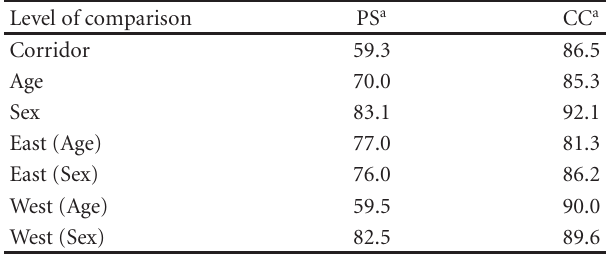
Table 5: Percent Similarity (PS) and Coe ffi cient of Community (CC) values for helminth communities of blue-winged teal ( Anas discors ) by host migratory corridor, host age, host sex, and age and sex within corridors.